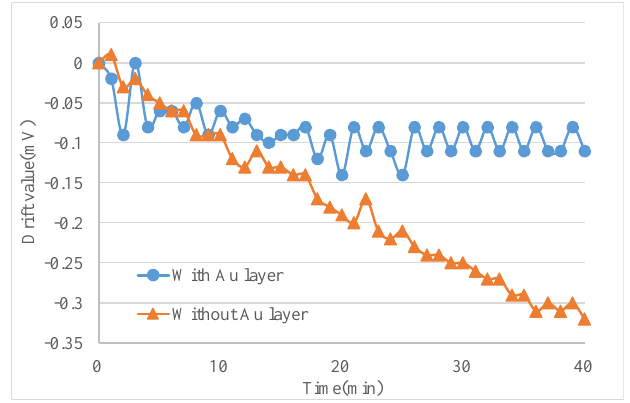
Figure 6. Shielding layer and test platform: ( a ) layout of shielding layer; and ( b ) sensors on platform.